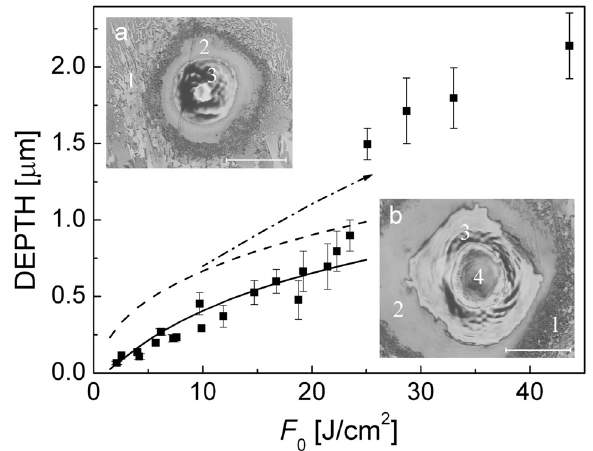
Figure 6. Measured ablation depth of a graphite target (averaged over the irradiation spot) as a function of laser fluence (dark squares) [50]. Modeling results on the ablation depth are shown by solid line. The onset of “ultradeep drilling” (phase explosion) is seen at ~22 J/cm 2 as a sudden increase in the ablation depth. The other lines show the calculated maximum depths of melting (with respect to the initial target surface) obtained with the thermal model taking into account plasma shielding (dashed line) and, additionally, with contribution of plasma radiative heating (dot-dashed line). Details of the calculations are given in [50]. The insets show optical microscope images of craters formed on the graphite surface by 30 consecutive laser shots at fluences ( a ) 3 J/cm 2 and ( b ) 24 J/cm 2 . The scale bar corresponds to an irradiated spot size (1/ e 2 level) for both cases. Several zones can be marked out: (1) non-damaged surface, (2) an external area of the irradiated spot where laser energy is insufficient to induce melting, (3) a zone with clear traces of melting, and (4) a deep area in the middle of the irradiated spot with a smooth bottom where melting traces are hardly